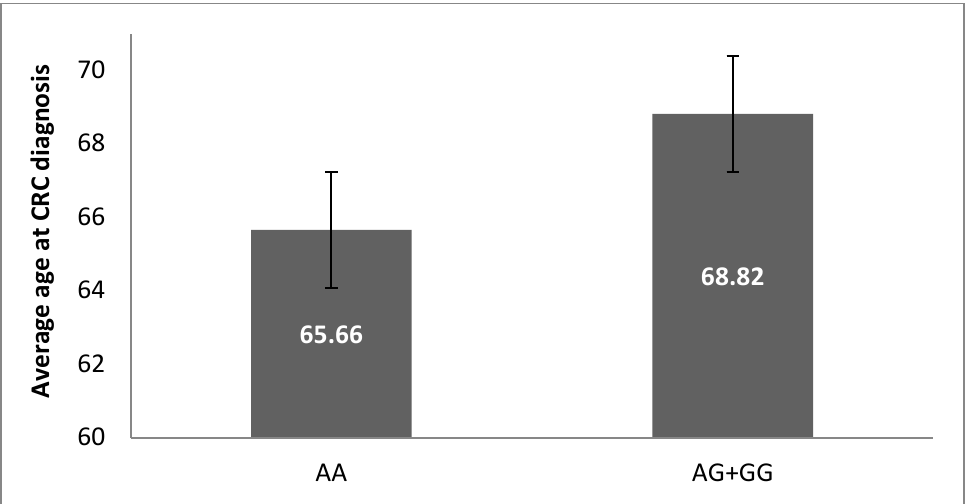
Figure 3. Association of IL17A -197 A/G genotypes and average age of diagnosis among CRC pa- tients. A tendency for lower age at diagnosis was observed for the carriers of the homozygous A/A- genotype.